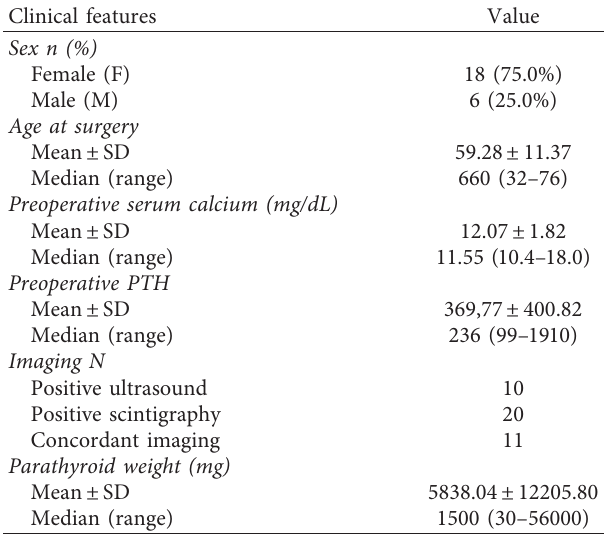
Table 6: Clinical features of patients with multiglandular disease ( n � 24).